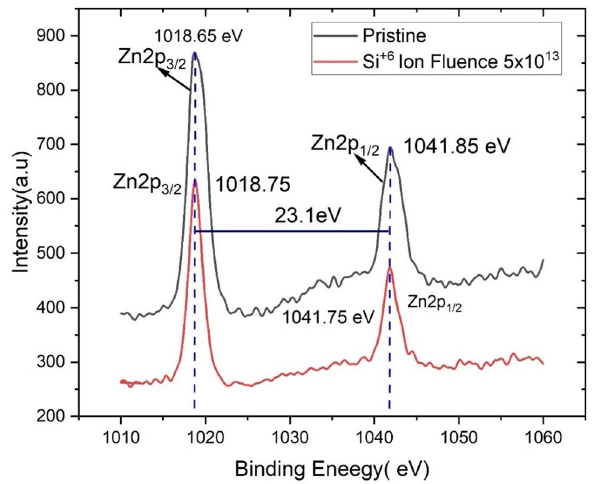
Figure 2. XPS spectra related to Zn binding energies for the pristine and Si 6+ ion beam irradiated ZnO:Ga thin film.